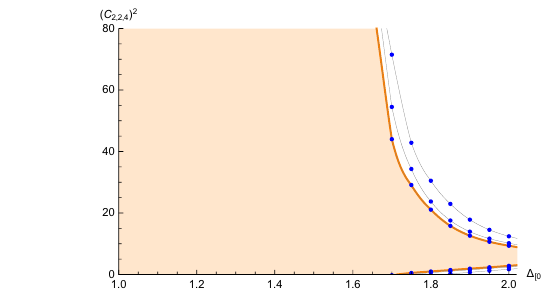
Figure 11 . Left: upper bounds on the OPE coe(cid:14)cient C 2 no lower bounds. One the right: upper/lower bounds on the OPE coe(cid:14)cient C 2 of (cid:1) . The numerics are done for (cid:3) = 20 ; 30 ; 40. We see that increasing (cid:3) improves the [0 ; 0]